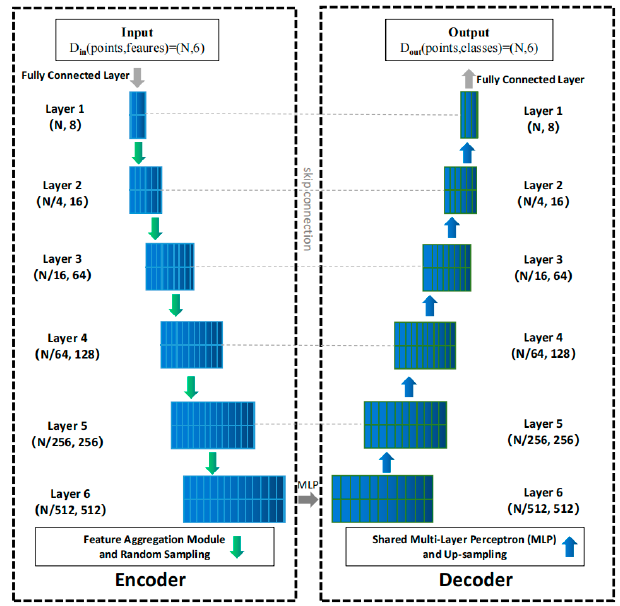
Figure 3. The framework of the deep learning network proposed in this paper.